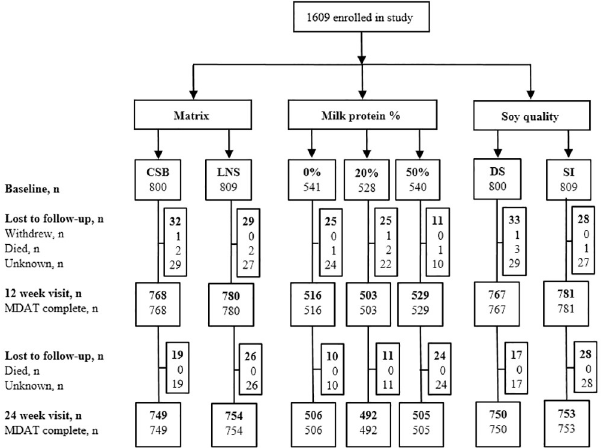
Fig 2. Trial profile. CSB, corn–soy blend; DS, dehulled soy; LNS, lipid-based nutrient supplements; MDAT, Malawi Development Assessment Tool; SI, soy isolate.